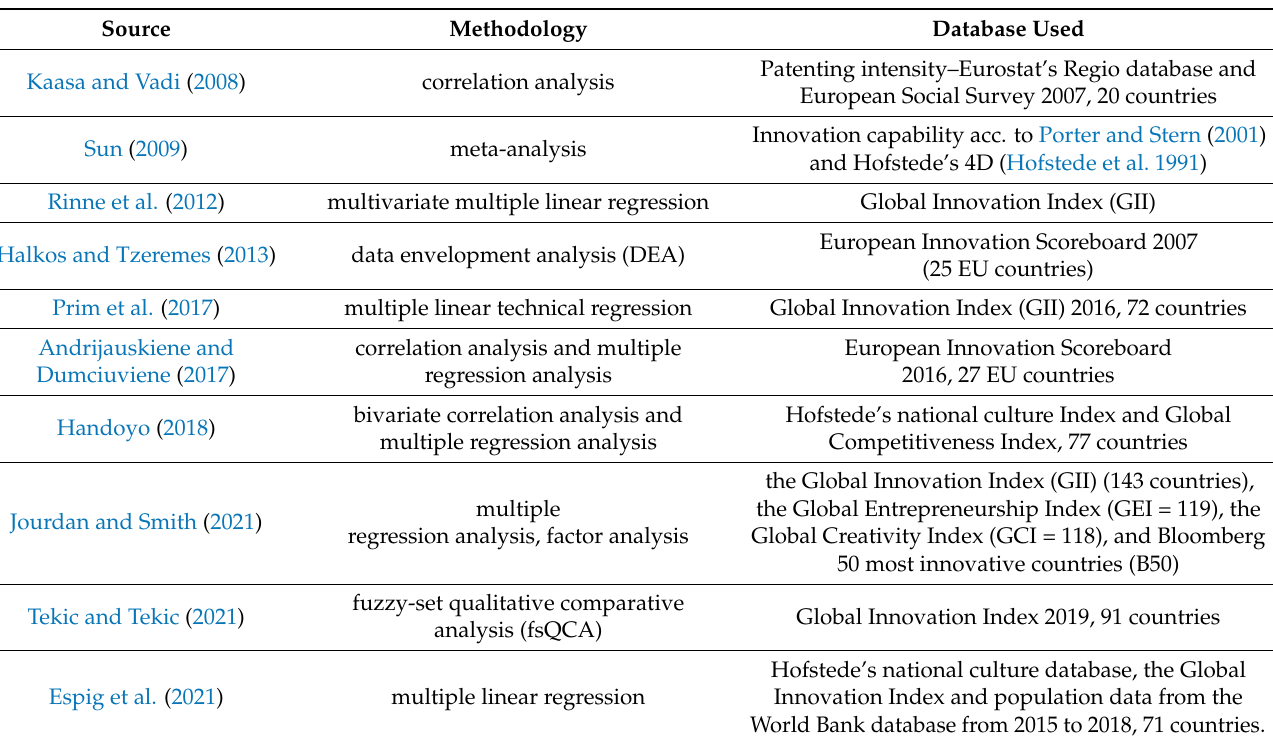
Table 1. Methodologies and databases used in research on the relationship between Hofstede’s dimensions and